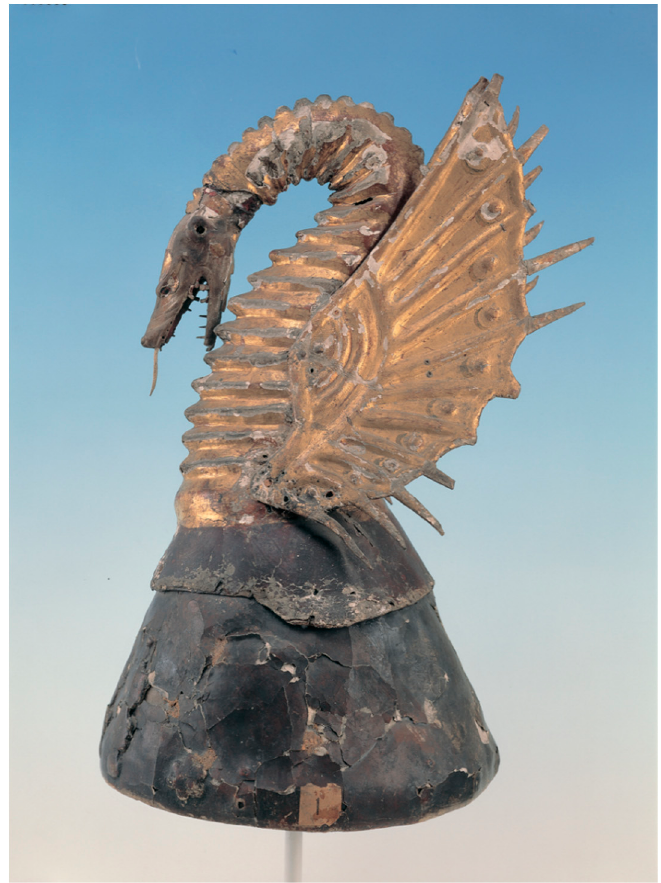
Figure 9. Crest with a dragon, also known as king Martin’s crest. Madrid, Armería Real (D.11). Used by permission.